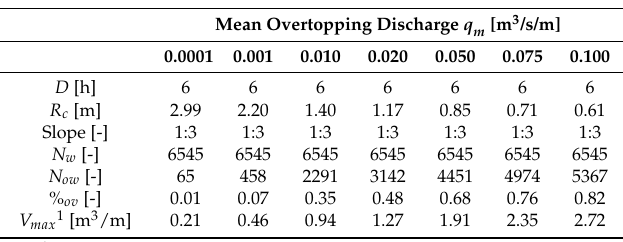
Table 3. Characteristic values of dike configurations and 7 tested storm boundary conditions for riverine dikes for the tested range of overtopping